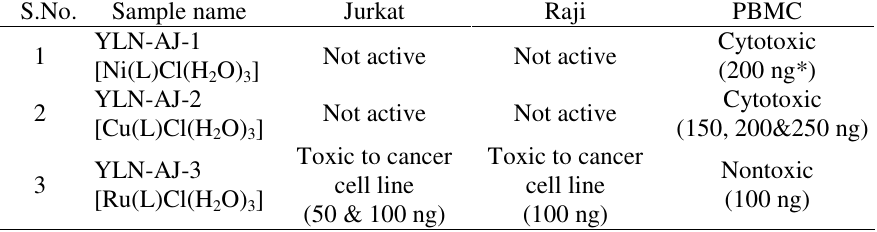
Table 3. Experimental results for samples screened on cancer cells